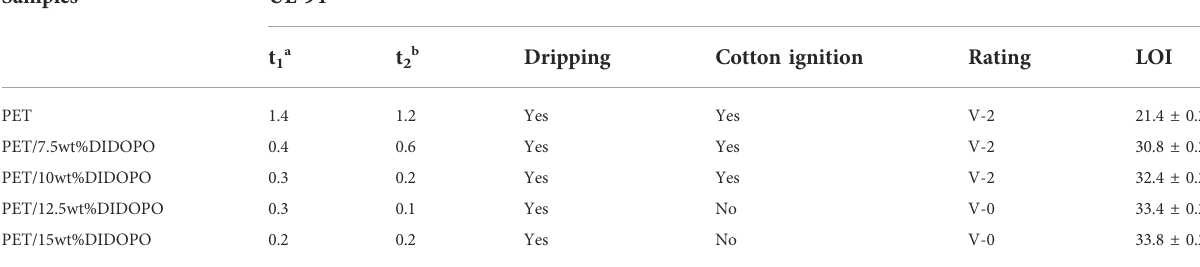
TABLE 1 The UL-94 vertical burning and LOI test results of PET/DIDOPO conjugated fl ame retardant composites.